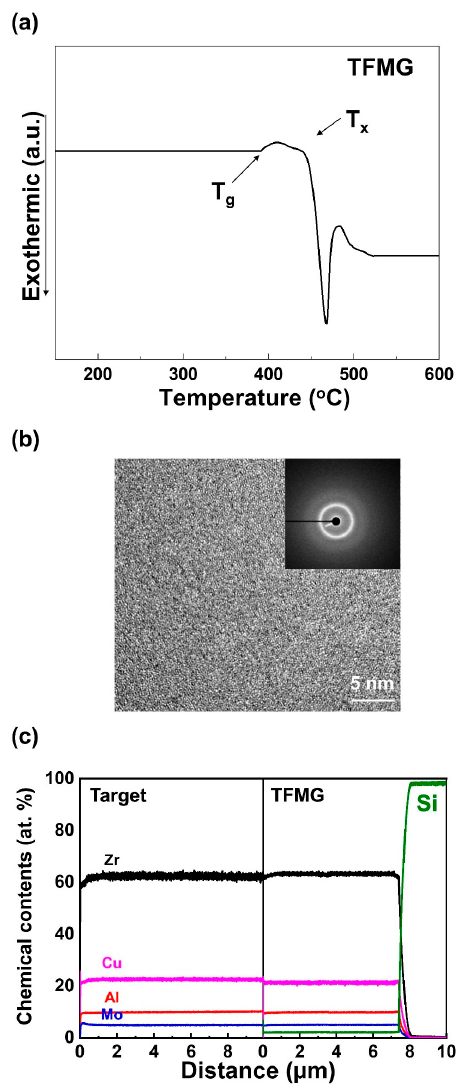
Figure 8. Analysis results for TFMG deposited using a crystalline target annealed at 800 °C. ( a ) DSC curve of TFMG. ( b ) TEM plane-view micrograph of ZrAlCuMo TFMG with inset SAED. ( c ) GDOES results of target and deposited TFMG at 300 W.